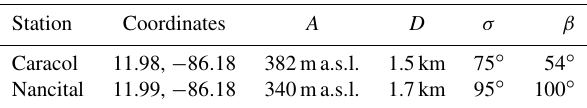
Table 1. Spatial set-up of the NOVAC stations at Masaya: alti- tude A , horizontal distance D to and angular orientation σ to the volcanic edifice, and orientation of the scan plane β (see Figs. 1 and